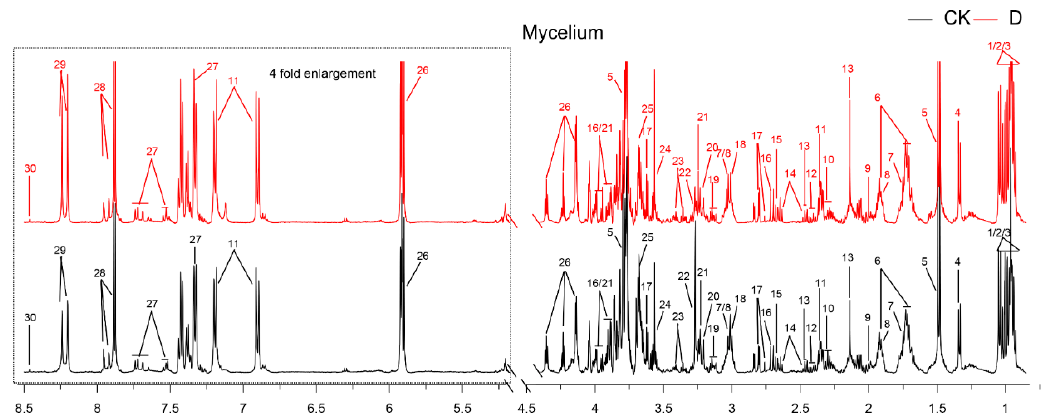
Figure 3. The typical 500 MHz CPMG 1 H-NMR spectra for 2 groups. Keys: 1. Isoleucine; 2. Leucine; 3. Valine; 4. Lactate; 5. Alanine; 6. Lysine; 7. Putrescine; 8. 4-Aminobutyrate; 9. Acetate; 10. Glutamate; 11. Acetaminophen; 12. Succinate; 13. Glutamine; 14. Glutathione; 15. 5,6-Dihydrouracil; 16.